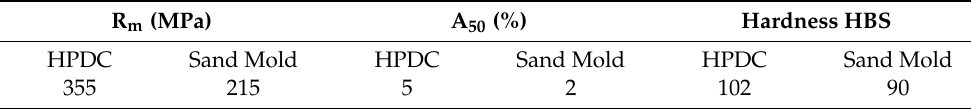
Table 2. Mechanical properties of the ZnAl4Cu3 alloy.